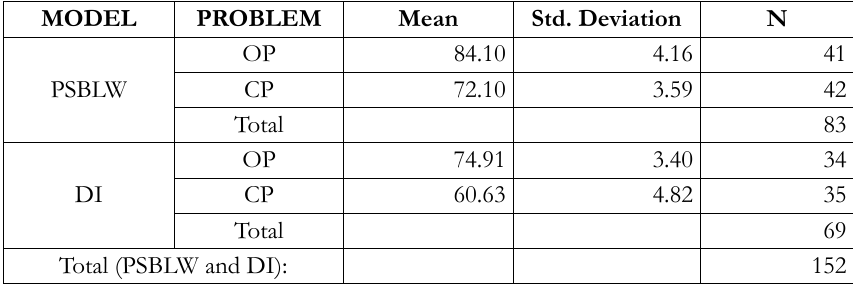
Table 3. Results of the Posttest of the ability to Solve Problems in Each Group of